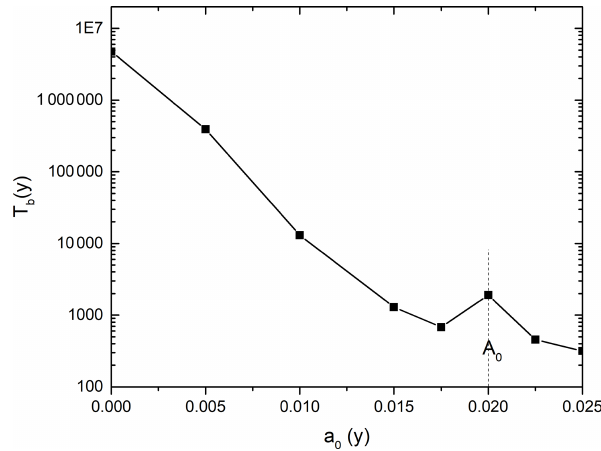
Figure 22. Breakthrough time of a network with a central frac- ture A 0 = 0 . 02cm embedded into a network of fractures with initial aperture a 0 as a function of a 0